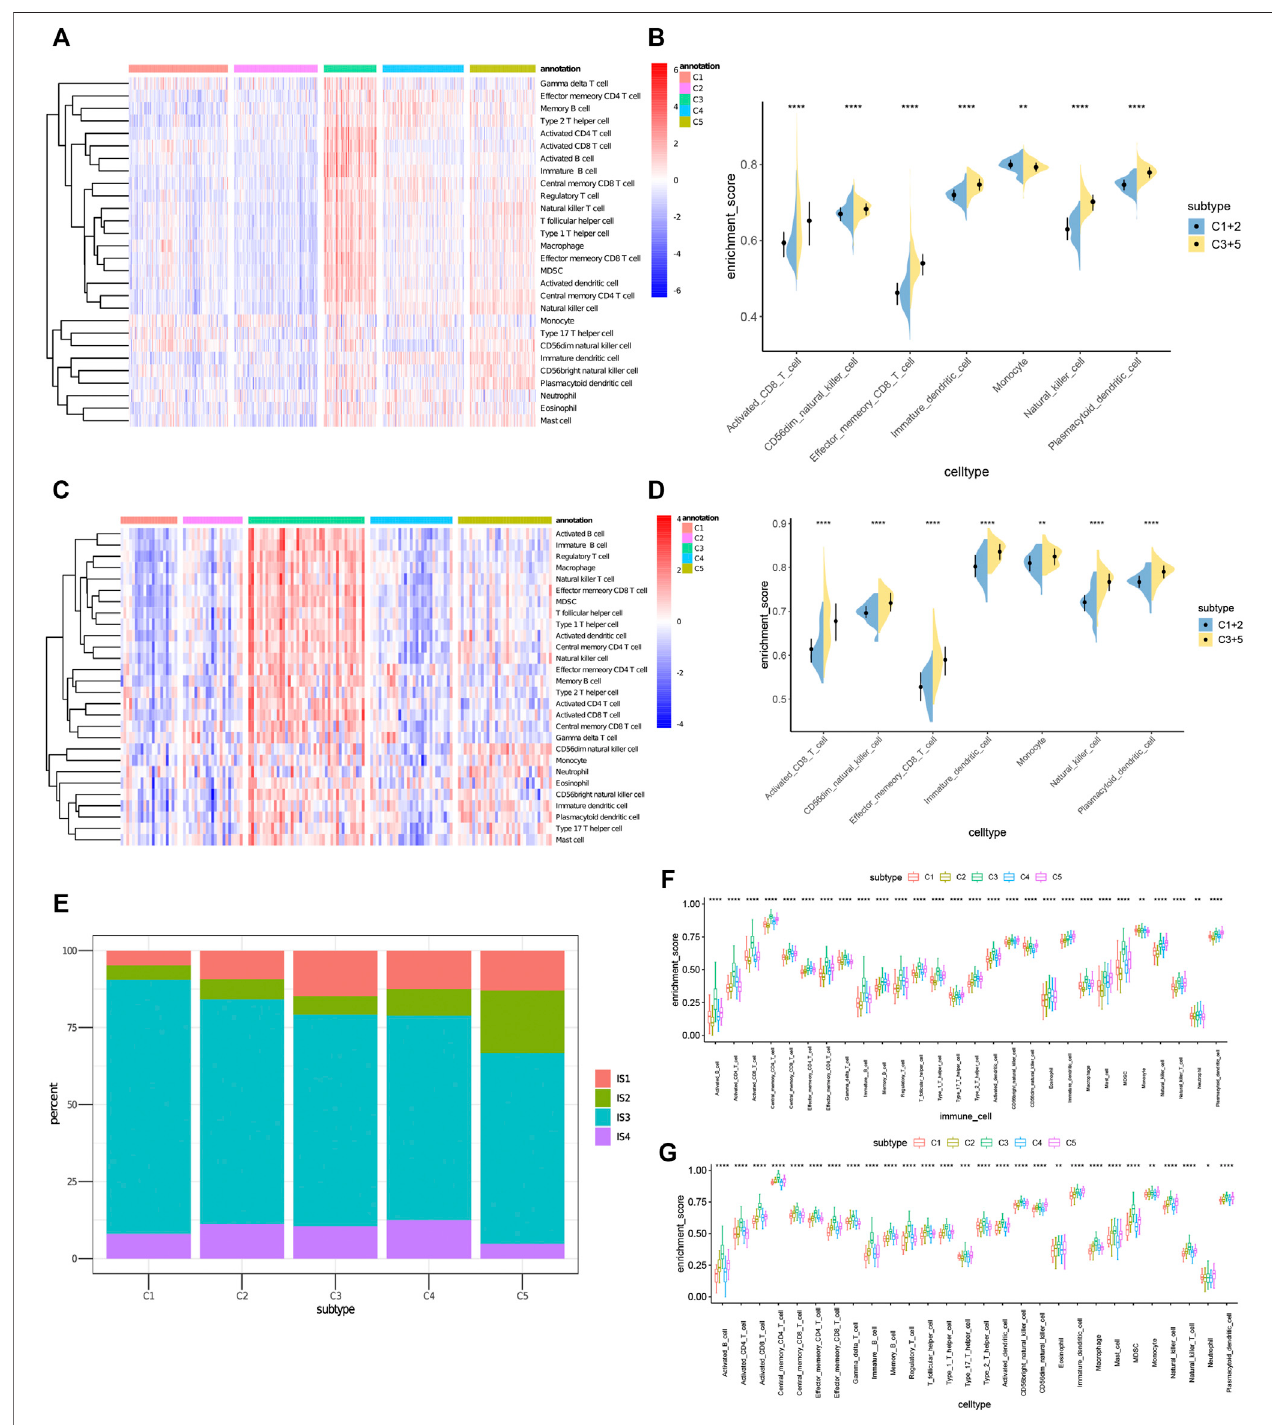
FIGURE 8 | Cellular and molecular characteristics of immune subtypes. (A,C) Differential enrichment scores of 28 immune cell signatures among PRAD immune subtypesin (A) TCGAand (C) ICGCcohorts. (B,D) Differentialenrichmentscoresof7prognosticallyrelevantimmunecellsignaturesin (B) TCGA and (D) ICGCcohorts. (E) Overlap of PRAD immune subtypes with 4 pan-cancer immune subtypes IS1-IS4. (F,G) Differential enrichment scores of 28 immune signatures among PRAD immune subtypes in (F) TCGA and (G) ICGC cohorts.